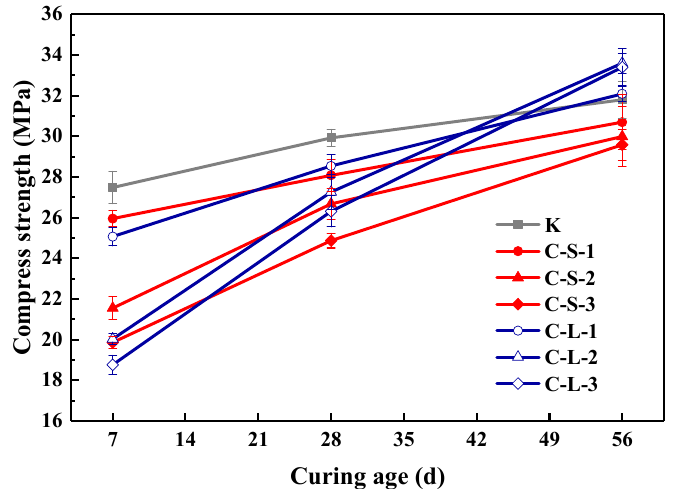
Figure 15. Compressive strength of mortar. Error bars indicate relative standard uncertainty in experimental measurements.